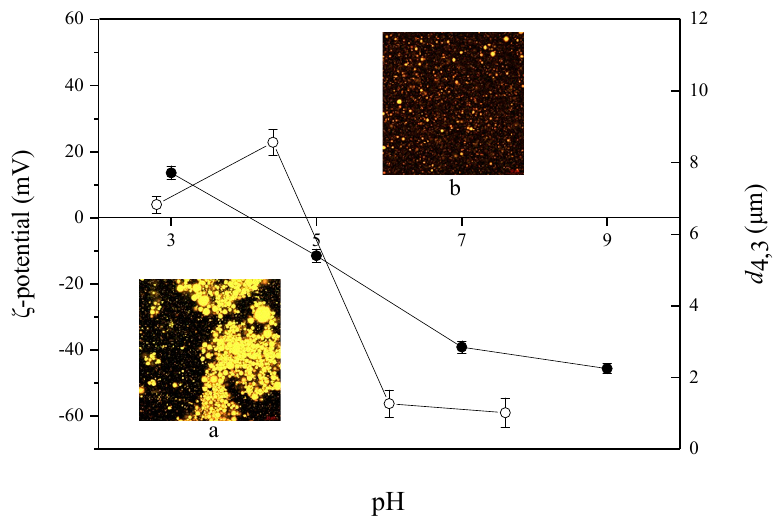
Figure 2. Influence of pH on ζ -potential ( ● ) and d 4,3 ( ○ ) of PSP-stabilized emulsions. Insets show the confocal laser scanning microscopy (CLSM) microstructures at ( a ) pH 5.0, ( b ) pH 7.0. Scale bar in the micrographs corresponds to 10 μ m. Values are means ± SDs (n = 3).